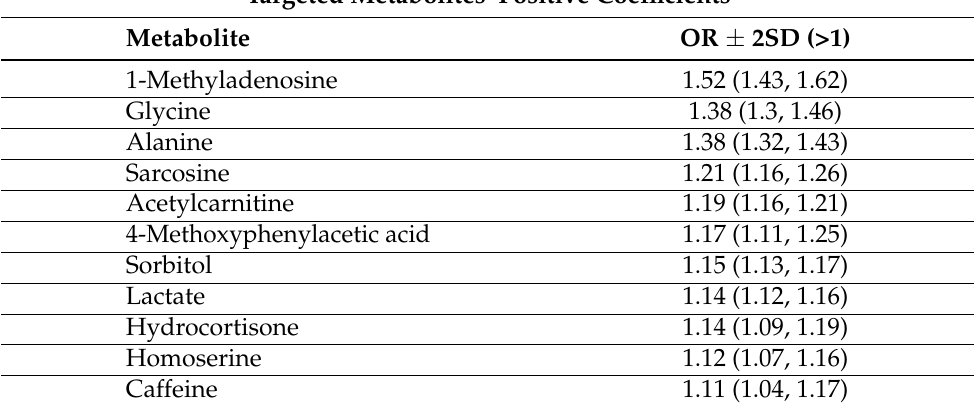
Table 2. Names and Odds Ratios (OR) for targeted metabolites and lipids retained in all five imputations of elastic net models fit on the full data to classify AD patients against controls. The tables are sorted by magnitude and split into positive and negative coefficient tables. Because the features were standardized prior to fitting the models, these ORs represent the expected odds ratio resulting from a standard deviation increase in concentration. Only ORs with magnitude greater than 1.1 or less than 0.9 are shown here. A two standard deviation interval is shown for the OR to quantify variability across the five missing data